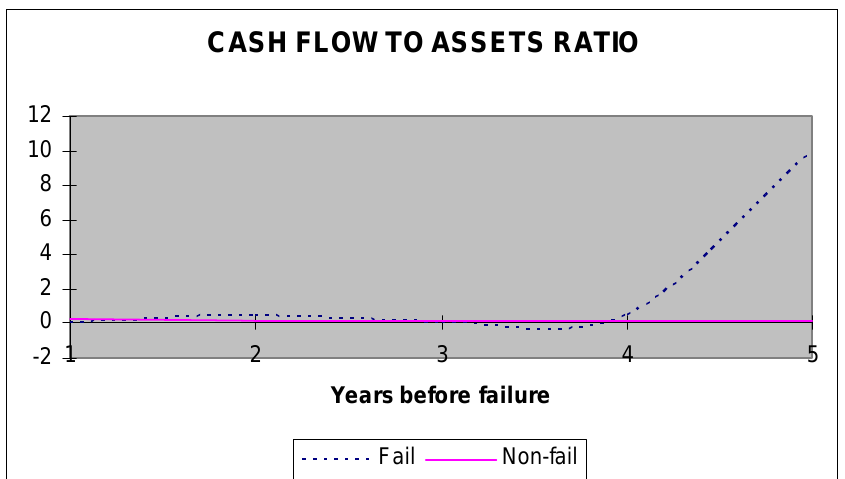
Figure 2: Cash flow to assets ratio CASH FLOW TO ASSETS